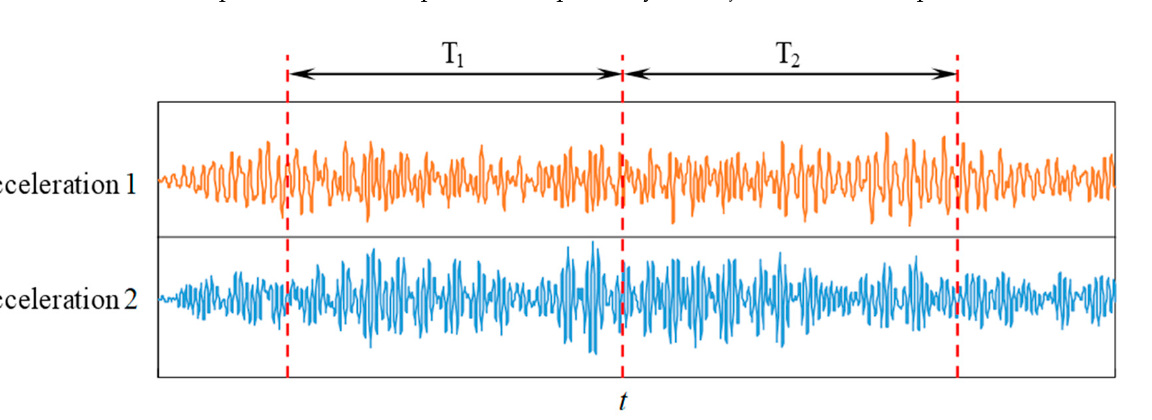
Figure 2. Acceleration responses of measurement points in different time periods.